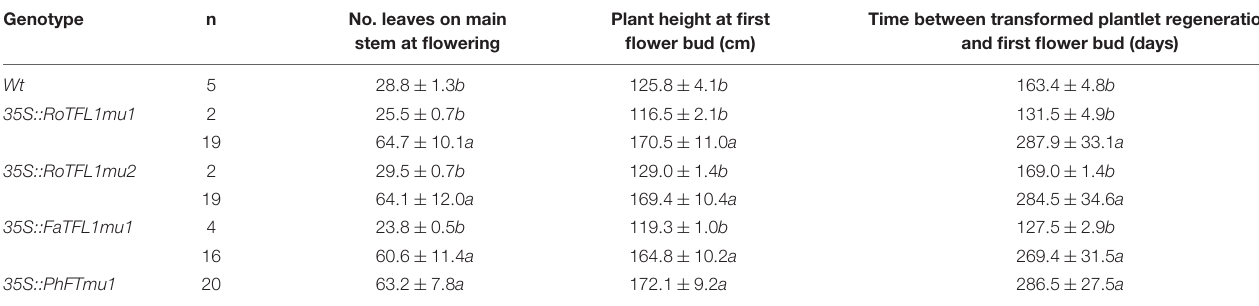
TABLE 3 | Flowering phenotypes of regenerated T 0 transgenic tobacco lines harboring mutated TFL1 -like transcripts. Genotype n No. leaves on main Plant height at first Time between transformed plantlet regeneration stem at flowering flower bud (cm) and first flower bud